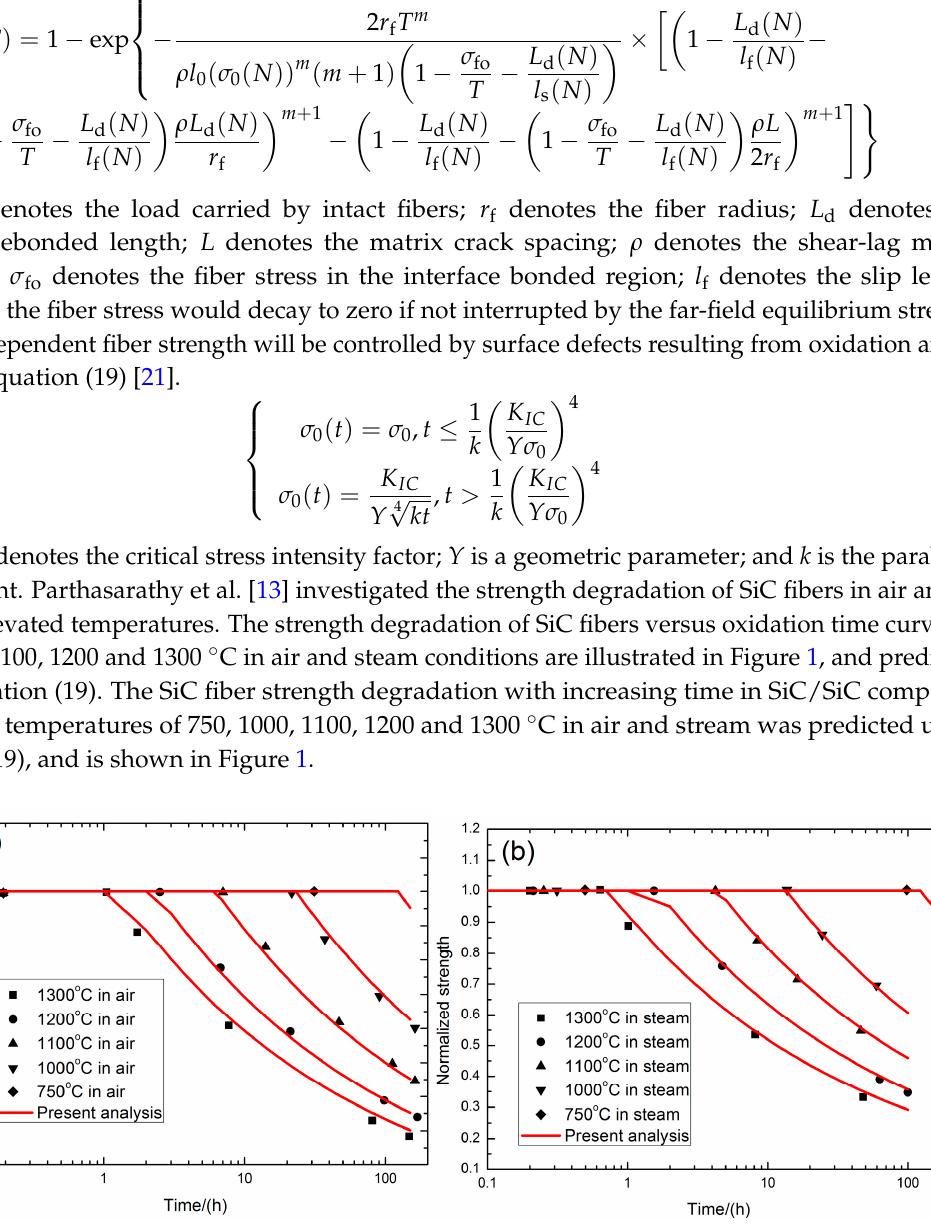
Figure 1. The strength degradation of SiC fibers ( a ) in air and ( b ) in steam conditions at elevated